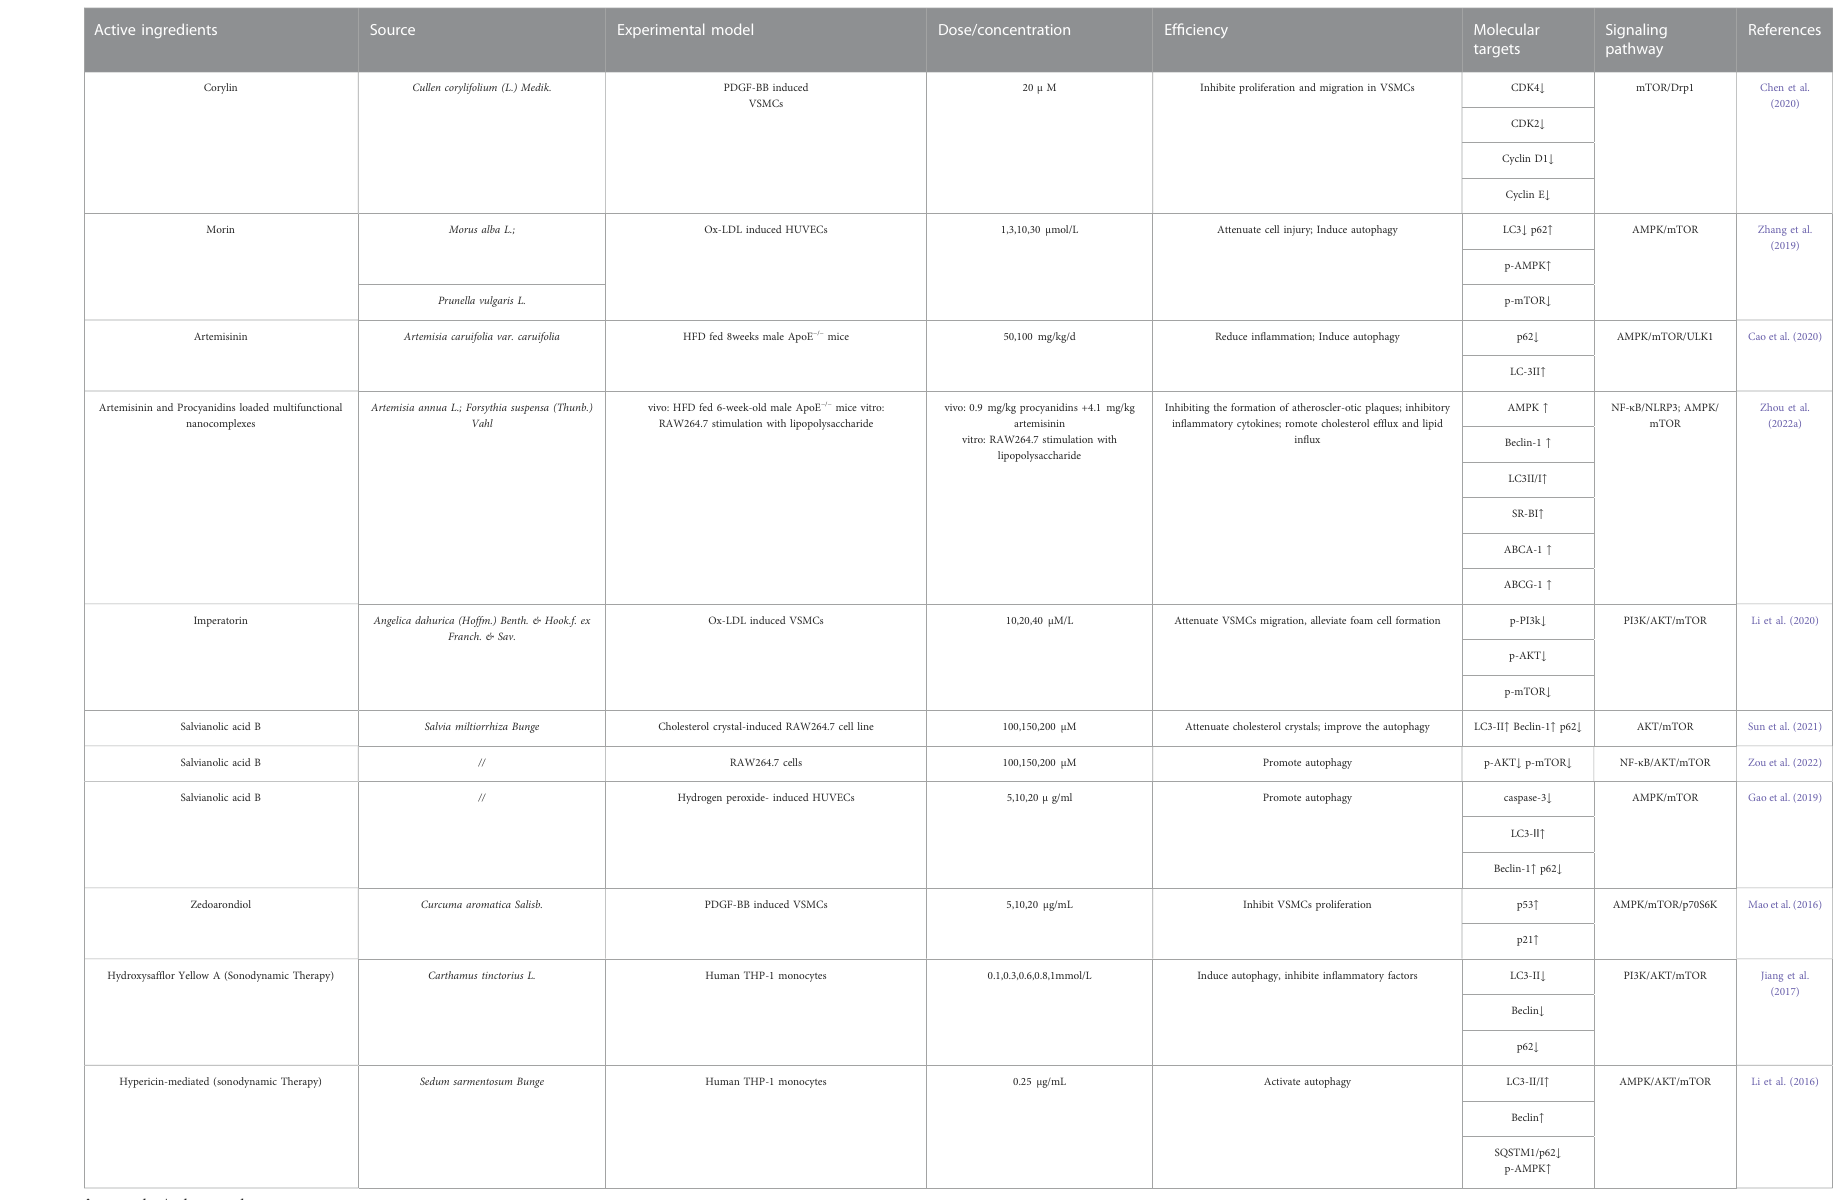
TABLE 4 Summary of the effects of other natural compounds on different AS